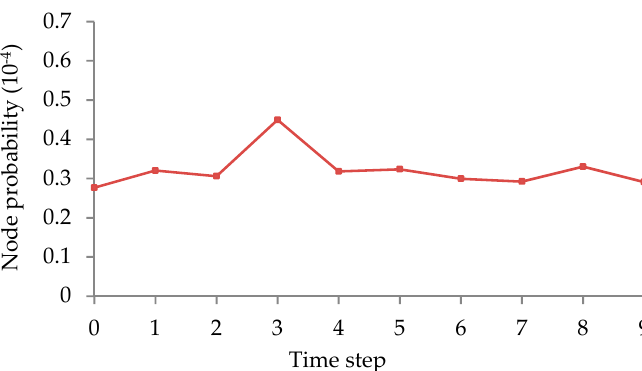
Figure 6. Time series variation curve of the dam breach probability.